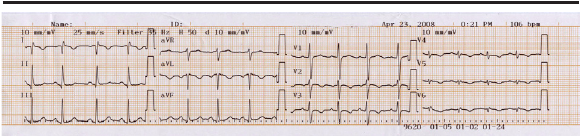
figure 4. ecG with conventional positioning of leads showing inverted P-waves in lead I